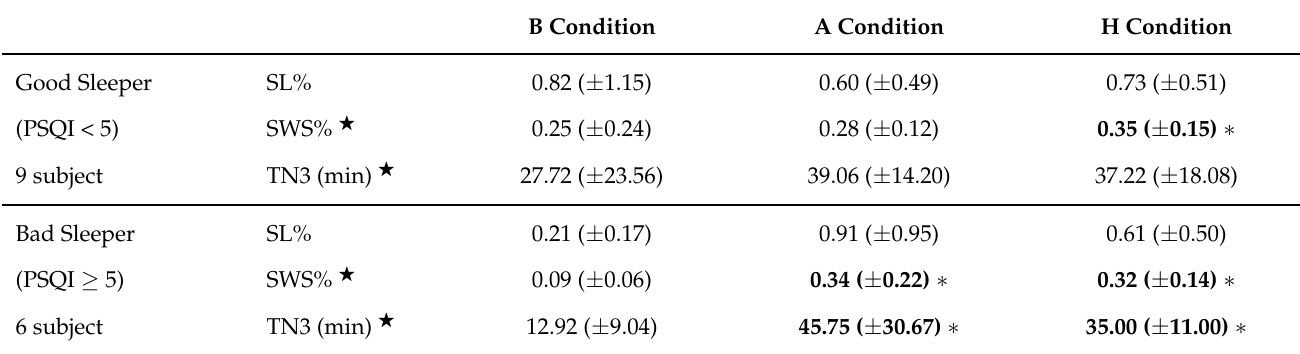
Comparison of the quantitative sleep parameters between two groups separated by PSQI levels ‘Good Sleeper’ and ‘Bad Sleeper’.